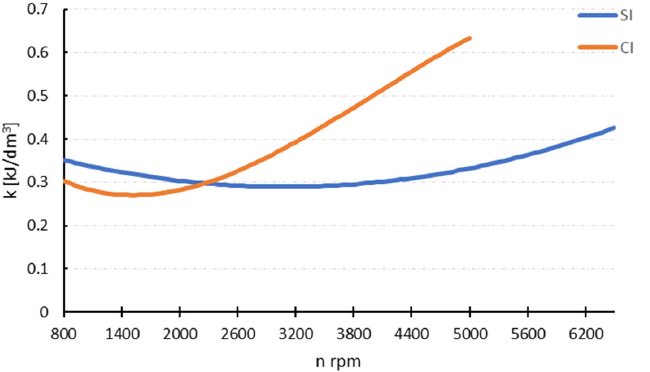
Figure 2. The engine friction factor for Vehicle 1 (SI engine), and Vehicle 2 (CI engine).